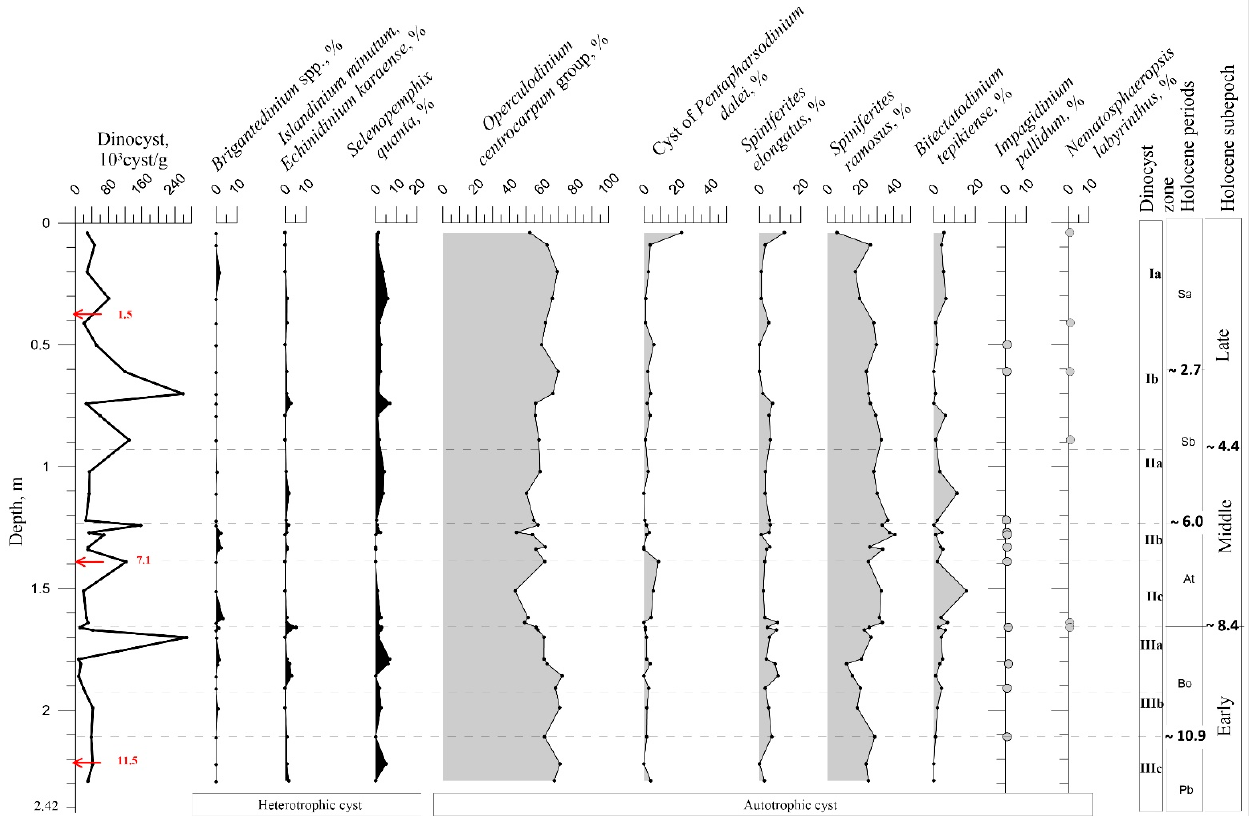
Figure 6. Dinocyst concentrations and relative abundance (percentages of the main taxa in core PS-6066. Dark gray and light gray mark heterotrophic and autotrophic species, respectively. The Holocene stages and dinocyst ecozones are marked on the right. Age model dates in cal kyr BP are marked in red, and boundary dates in cal kyr BP are in black.